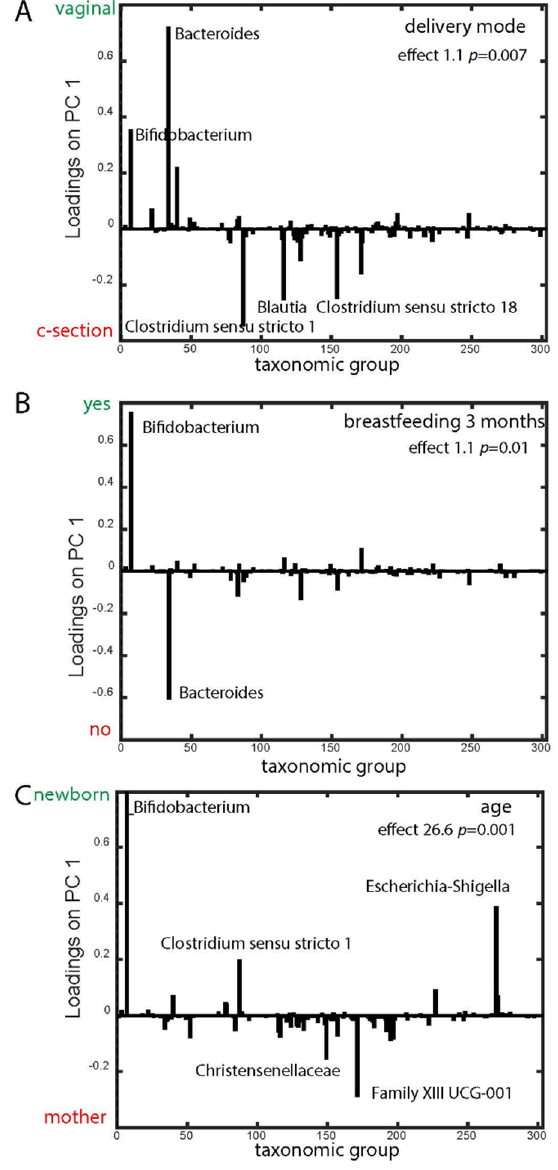
Figure 4. Metadata association with microbiota. ANOVA-simultaneous component analysis (ASCA-ANOVA) was used to determine the association of microbiota to known factors of the children. The Principal Component Analysis (PCA) plot shows the effect (Y-axis) of delivery method: vaginal and C-section ( A ), breastfeeding between 3 and 6 months of age ( B ), and age ( C ) based on the taxonomic groups acquired from 16S rRNA sequencing (X-axis). ( C ) The Y-axis is a gradient of age, where the effect points towards a young age or old age, showing the outer points of the scale: newborns and mother.